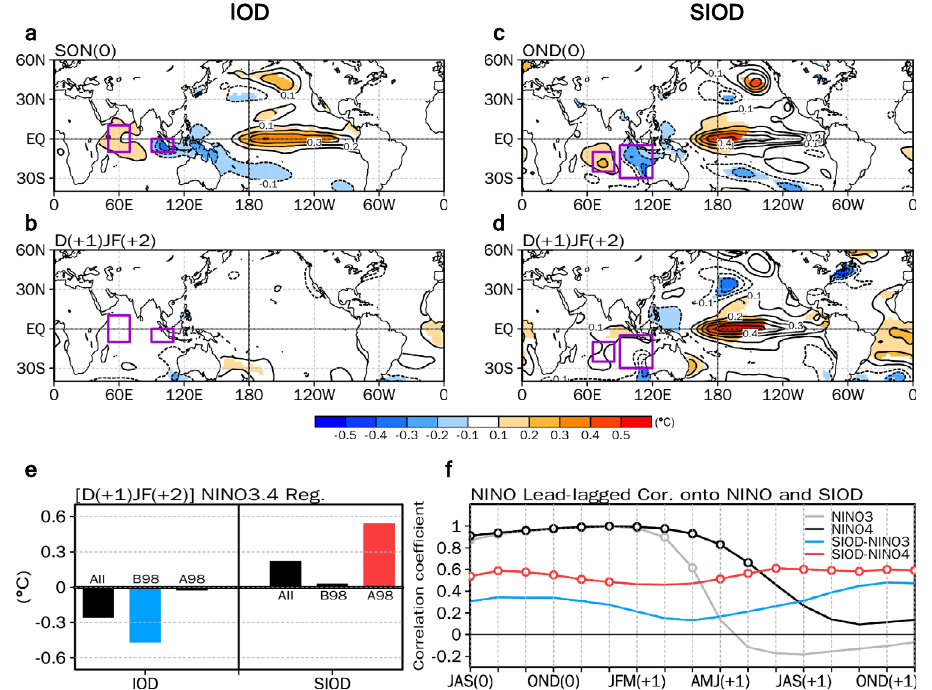
Fig. 2 | Southern Indian Ocean Dipole as a precursor of the ENSO after the 2000s. Lagged regression maps of ( a ) sea surface temperature (SST) (°C) anoma- lies during boreal fall (SON) season and ( b ) subsequent year ’ s SST (°C) anomalies duringborealwinter(DJF)seasonwithrespecttothenormalizedSONIndianOcean Dipole (IOD) index from 1998 – 2019. ( c ) SST (°C) anomalies during boreal late fall (OND) season and ( d ) subsequent year ’ s SST (°C) anomalies during the DJF season with respect to the normalized OND Southern Indian Ocean Dipole (SIOD) index from 1998 – 2019. Shading in a − d denotes the region where the statistical sig- ni fi cance is above the 95% con fi dence level. e Regressions between the IOD, SIOD,